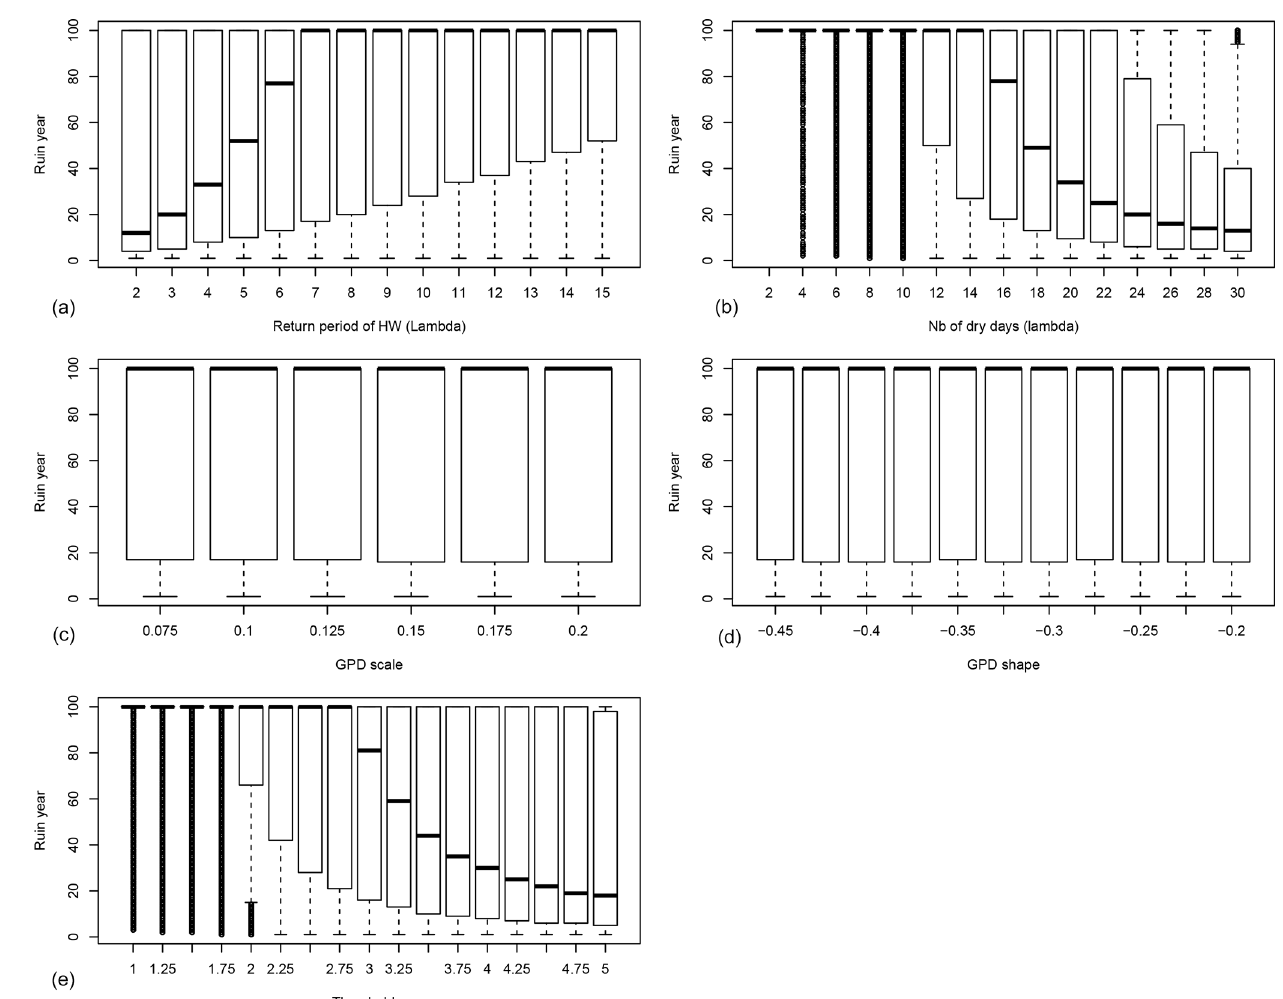
Figure 4. Probability distributions of the ruin year τ as functions of the drought–heatwave (HW) return period (cid:51) (a) , number of hot days during summer λ (b) , GPD fit scale σ (c) , GPD fit shape ξ (d) and the threshold u above which damage S ( t ) is triggered (e) . B = 0 . 4 in all experiments. For each value of the control variable, a boxplot is given. The thick horizontal bar in each box represents the median ( q 50) of the distribution. The boundaries of each box represent the 25th quantile ( q 25) and the 75th quantile ( q 75). Each upper whisker represents min [ max( τ ) , 1 . 5 × ( q 75 − q 25) + q 50 ] . Each lower whisker has the symmetric formulation. Data that are above or below the whiskers are shown as small circles; these circles are close to each other and therefore appear like thick vertical